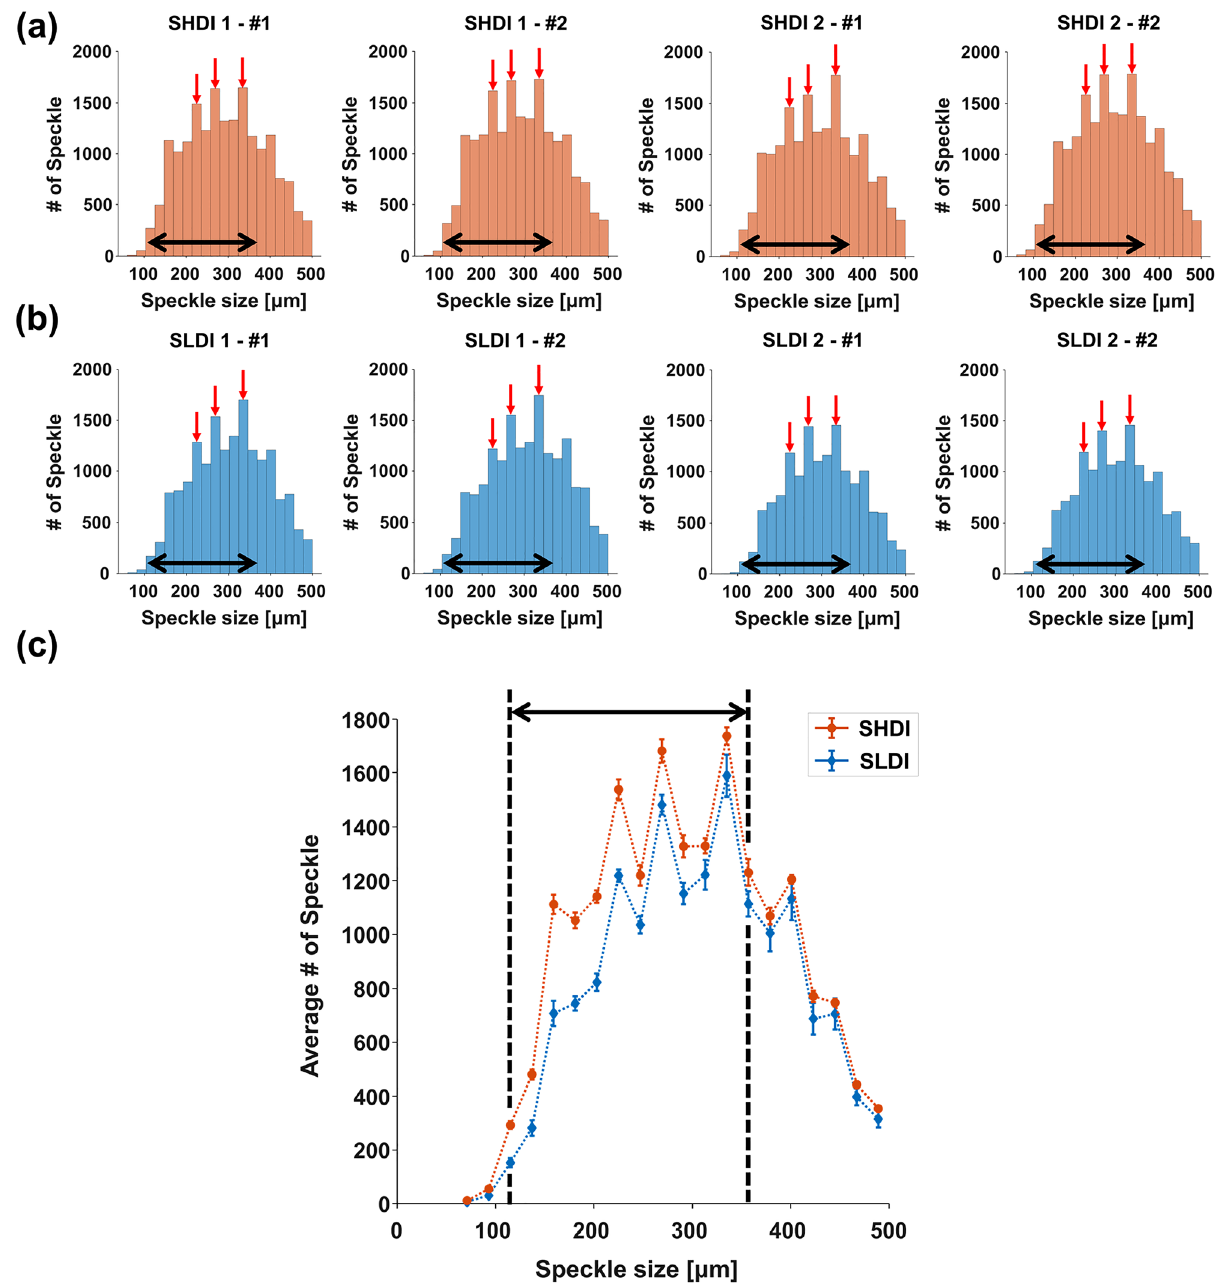
Figure 5. The size histogram results for each region. ( a ) The results of the steel sheets with high-density inclusions (SHDI), and ( b ) low-density inclusions (SLDI). Red arrows indicated the matched peak columns. ( c ) Mean values and standard error of the mean (SEM) of the speckle size for the SHDI and SLDI. Black arrows indicated the region with a greater number of speckles in the SLDI than SHDI. (plotted by: MATLAB R2018a— https:// www. mathw orks. com/ produ cts/ matlab.